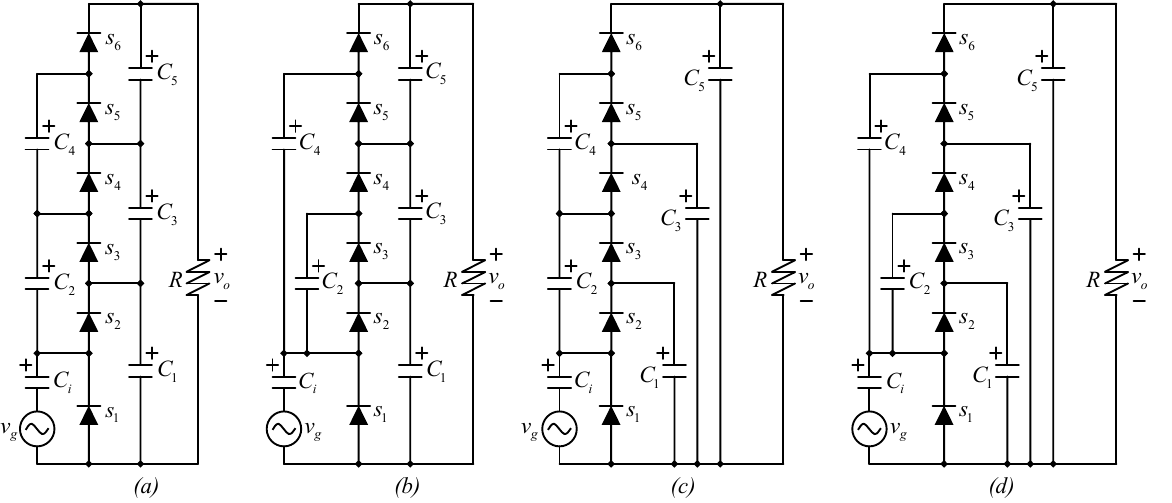
Figure 3. Several topologies of ac-to-dc switched-capacitor voltage multiplier ( × 6 multiplier) ( a ) both side series capacitor topology, ( b ) combination of grounded (left) and series (right) topology, ( c ) combination of series (left) and grounded (right) topology, and ( d ) both sides (left and right) grounded topology.